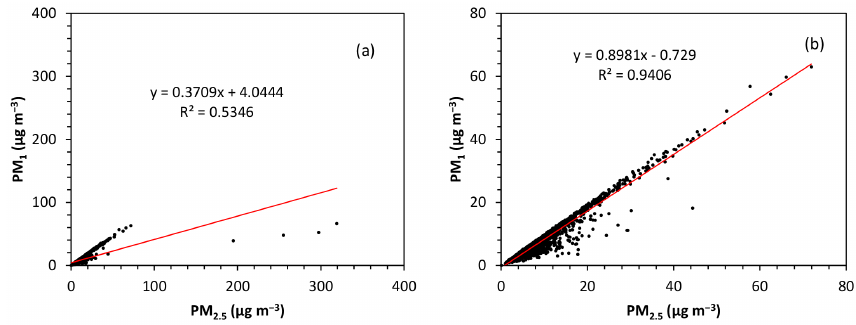
Figure 2. Scatter plots of PM 1 versus PM 2 . 5 (a) with and (b) without data from the strong sandstorm and dust storm at